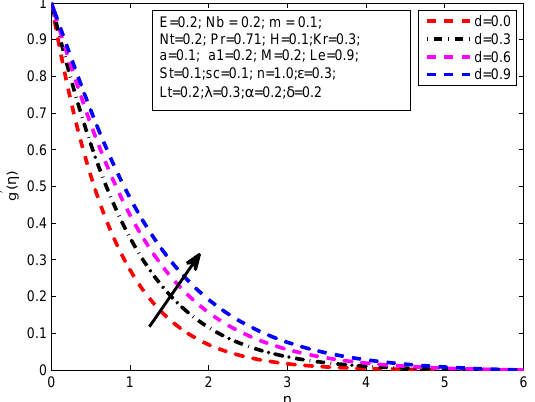
Figure 22. Variation of momentum profile for distinct values of d